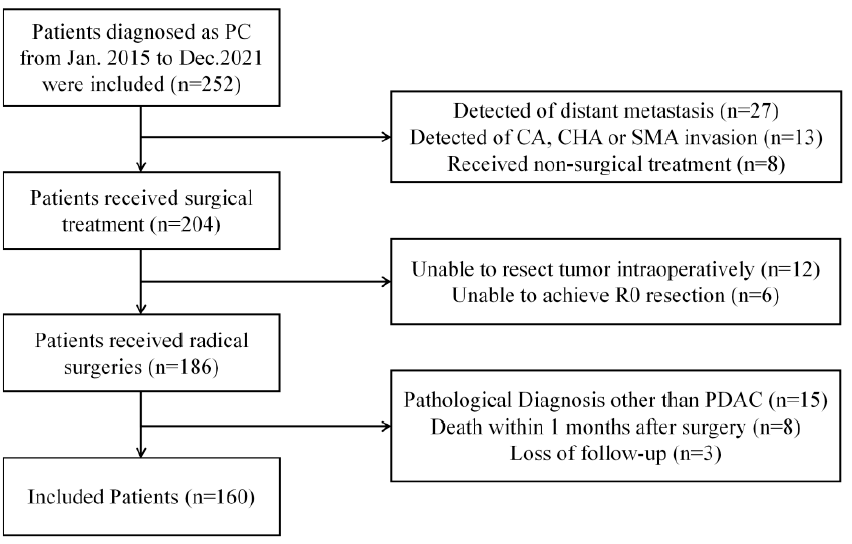
Figure 1. Flowchart of patient screening (PC: pancreatic cancer; CA: celiac axis; CHA: common hepatic artery; SMA: superior mesenteric artery; PDAC: pancreatic ductal adenocarcinoma). Inclusion criteria: (1) patients with pancreatic cancer who received surgical treatment from January 2015 to December 2021 in the Hepatobiliary Surgery Department, Beijing Chaoyang Hospital; (2) no restriction on age or gender; (3) no surgical contraindi- cation, including abdominal arteries invasion and distant metastasis on preoperative evaluation; (4) achieved en bloc resection intraoperatively; (5) postoperative pathologi- cal confirmation of the diagnosis of pancreatic ductal adenocarcinoma and